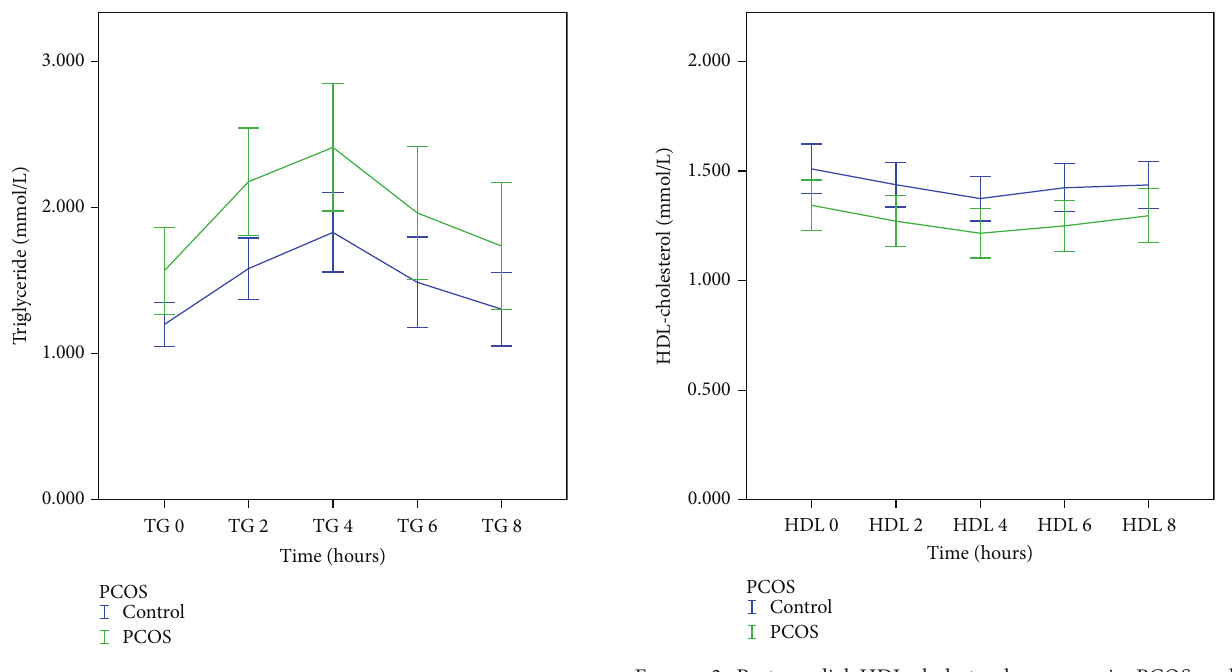
PCOS women ( 2.18±0.18 mmol/L versus 1.58±0.10 mmol/L, 𝑝 =